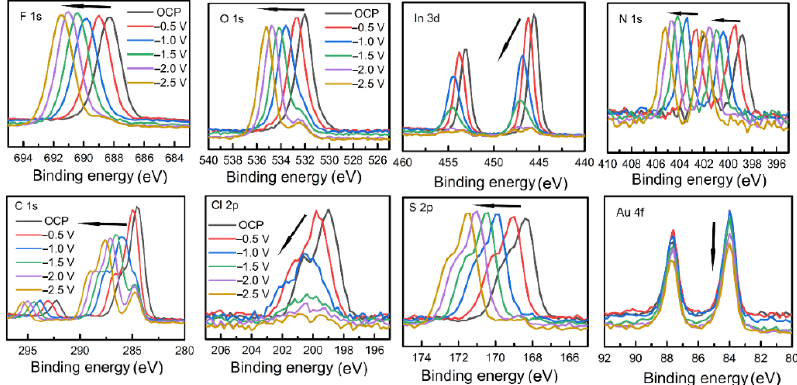
Figure 6. In situ XPS detail spectra of F 1s, O 1s, In 3d, N 1s, C 1s, Cl 2p, S 2p, and Au 4f core-level of 0.1 mol/L InCl 3 in [Py 1,4 ]TFSI at different potentials from OCP ( − 0.2 V) to − 2.5 V.